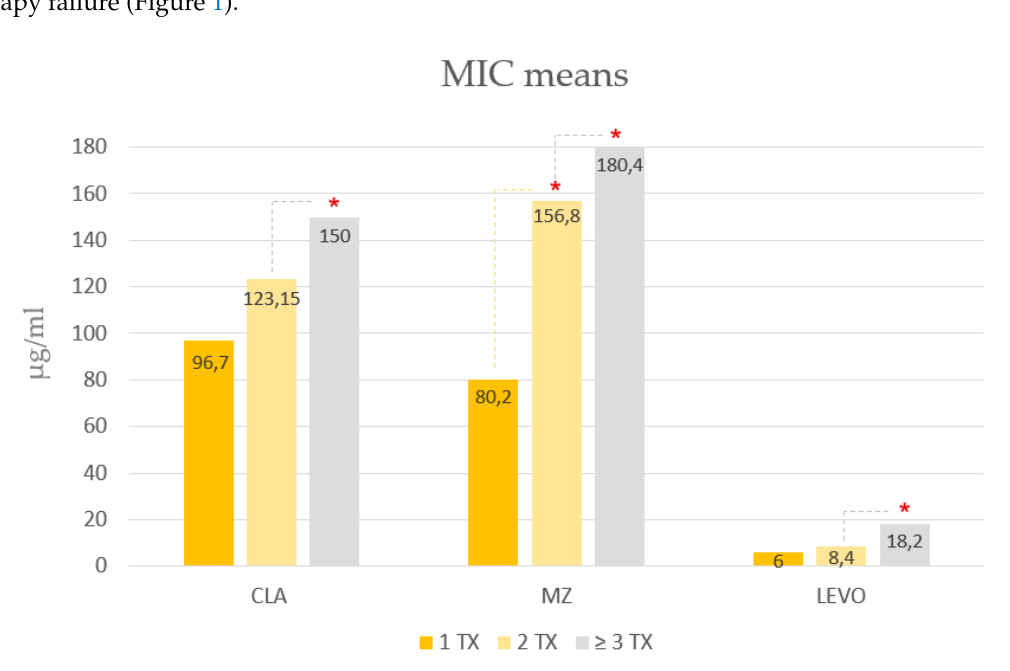
Figure 1. MIC values towards different antibiotics following one or more therapy failures. TX = therapy. Cla: clarithromycin. Mz: metronidazole. Levo: levofloxacin. * P < 0.05.